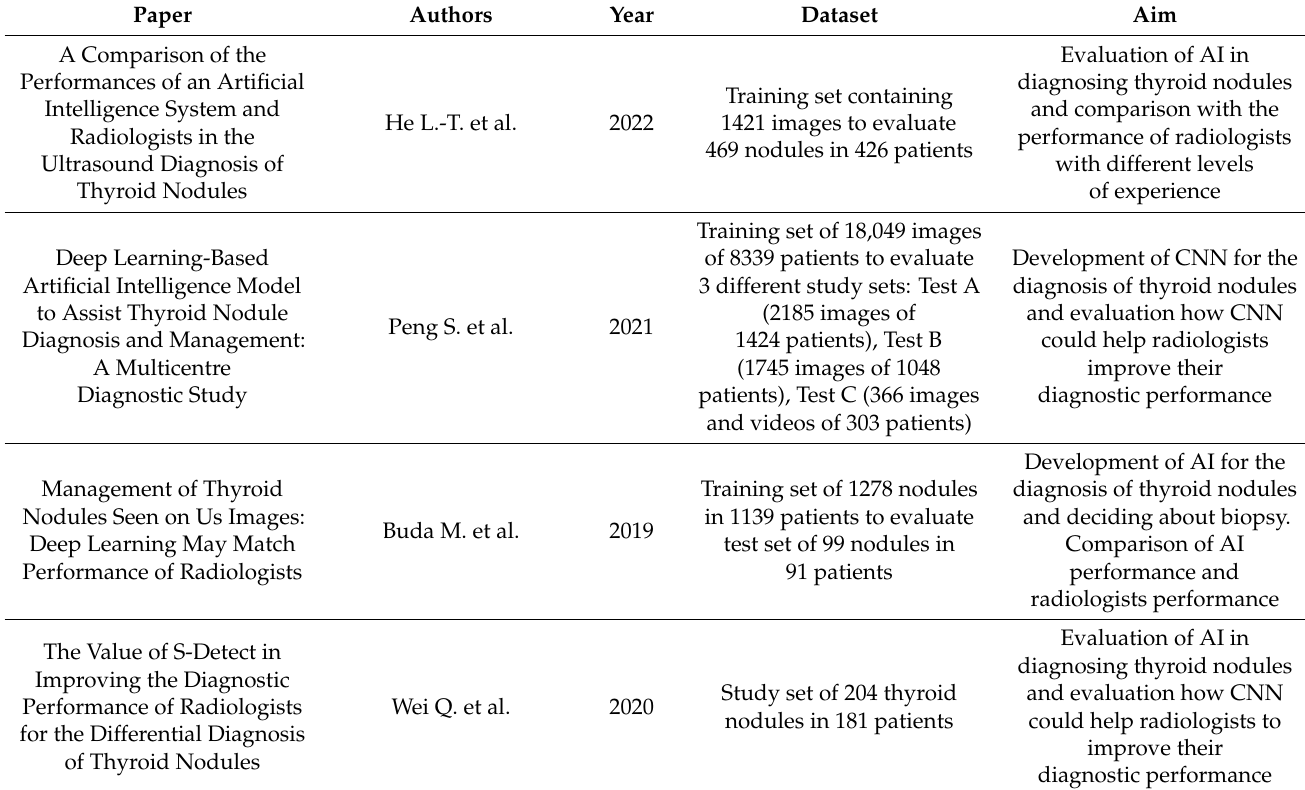
Table 5. Summary of the papers used in this